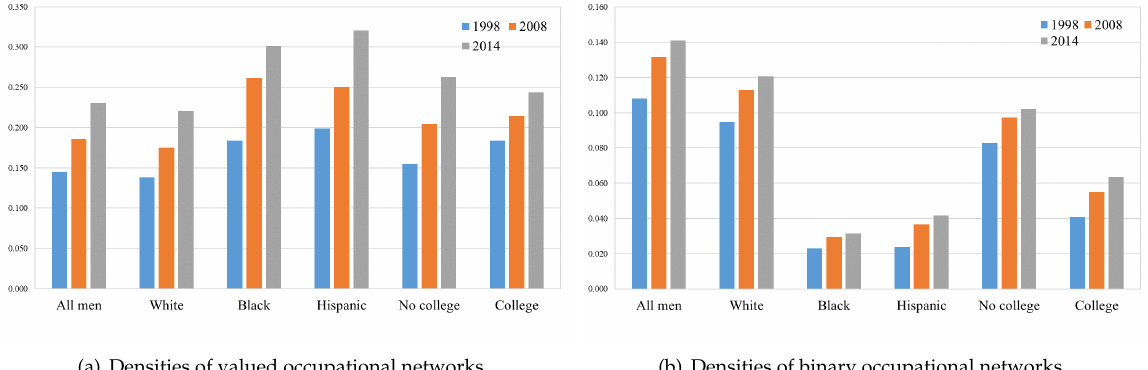
Figure 2: Densities of valued and full binary occupational networks for different sociodemographic groups, 1998 to